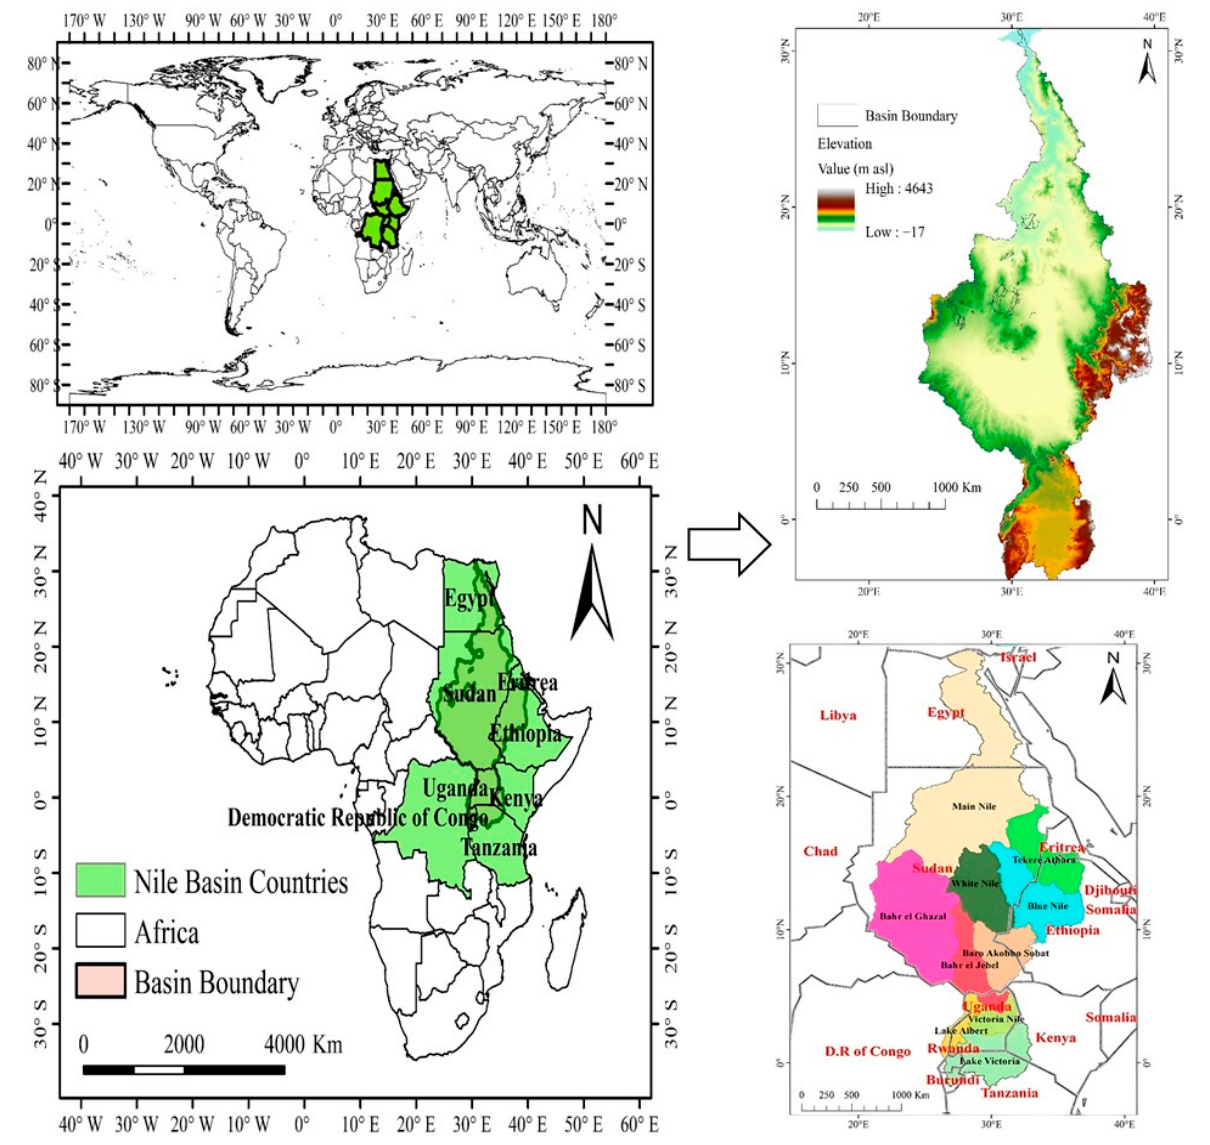
Figure 1. Location map of East Africa and NRB. The Digital Elevation Model (DEM) from the Hydrologic Derivatives for Modelling and Analysis (HDMA) database was used [43]. The map was developed using ArcGIS 10.6 (http://www.esri.com/software/arcgis/arcgis-for-desktop, accessed on 24 October 2021).